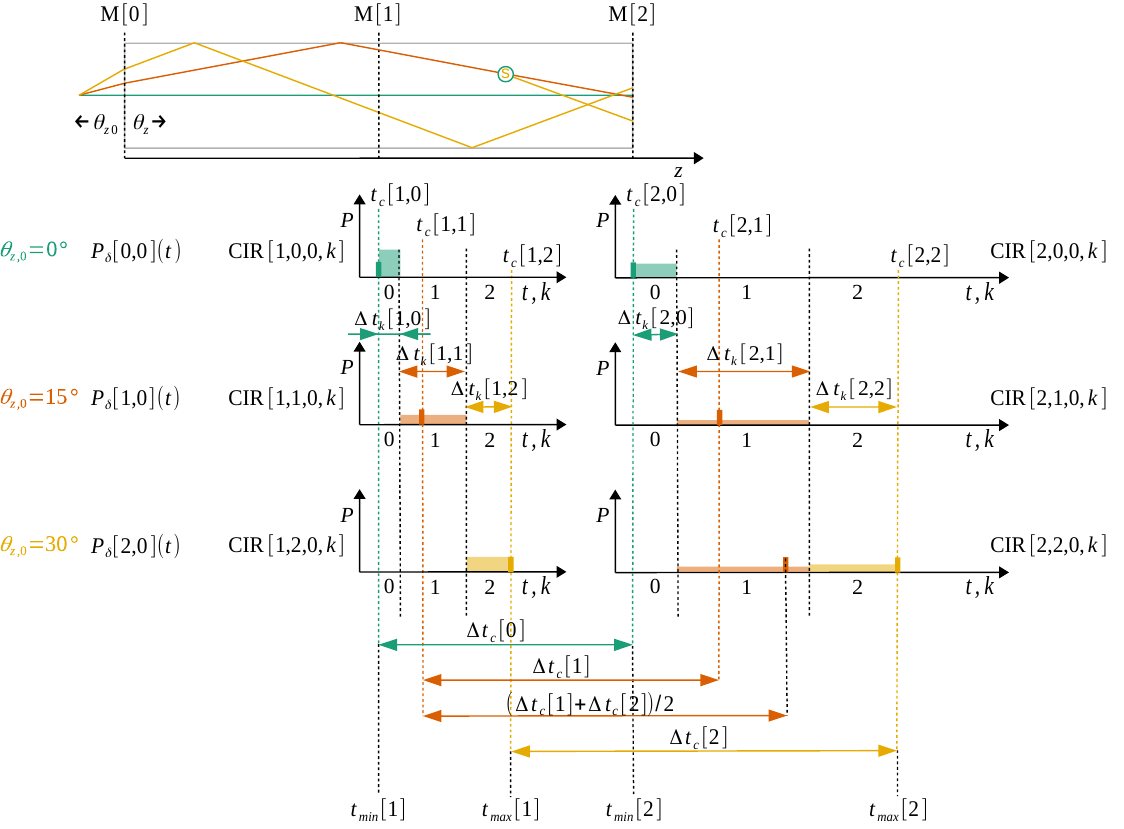
Figure 6. Cell impulse responses of the